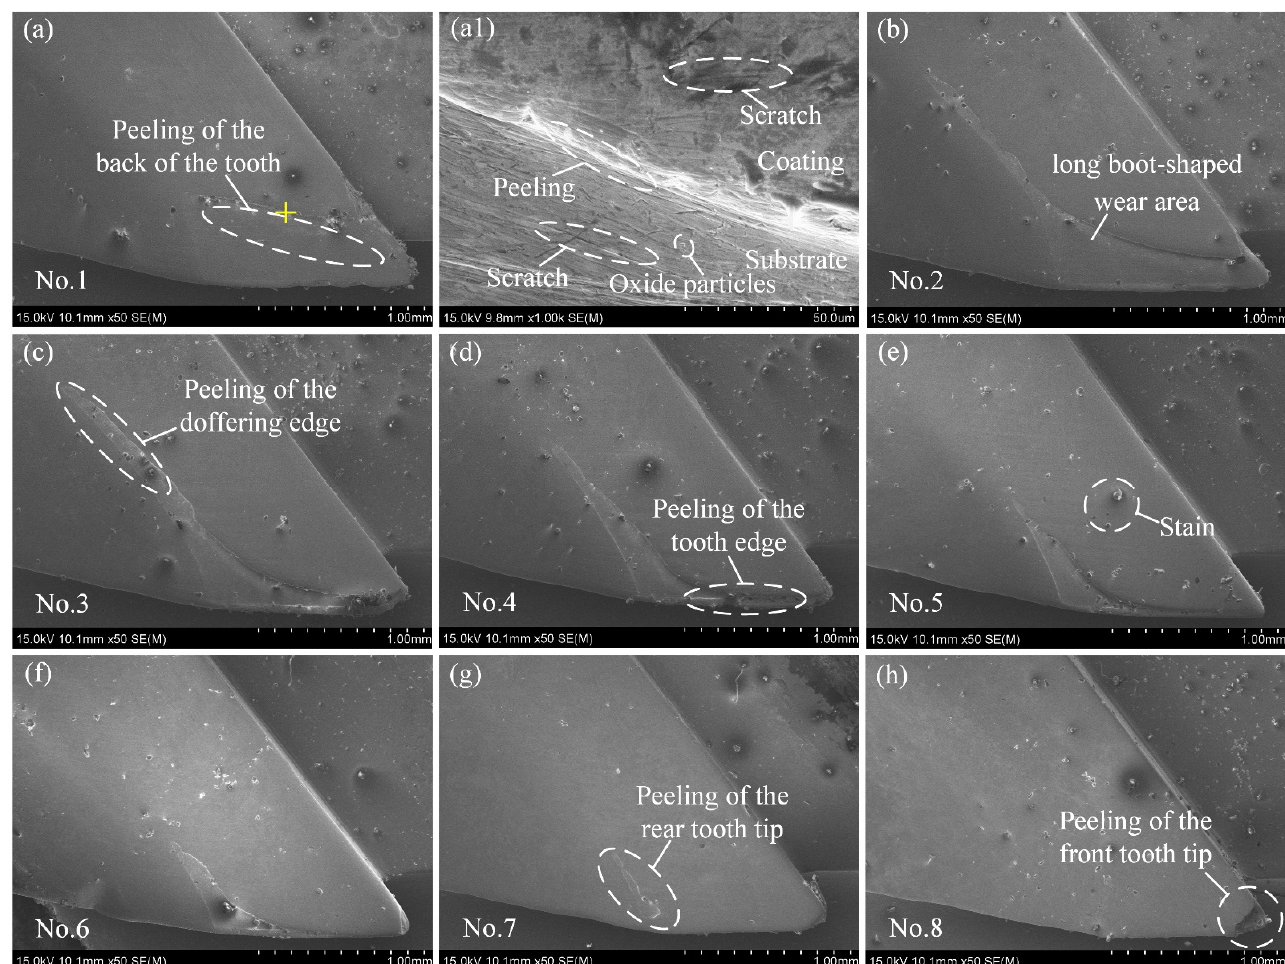
Figure 8. Wear morphology of hook teeth nos. 1 to 8 in a 450-hectare operation: ( a – h ) Wear morphology of hook teeth nos. 1 to 8; and ( a1 ) partial micrograph of the hook tooth nos. 1 mark. In sum, the wear of the spindle hook teeth starts from their front and rear tips before extending to their edges and back and then extending backward along the doffering edge to form a long boot-shaped wear area. Compared with hook teeth nos. 7 to 12, nos. 1 to 6 are more easily worn. The analysis results reveal that in the process of picking cotton, the hook teeth insert themselves into the cotton to hook the material, and given that the front and rear tooth tips are relatively sharp and the stress is concentrated, the front and rear tooth tips tend to be the first to wear out. In the process of picking cotton, the hook teeth on the edges and back of the teeth is prone to abrasive wear and even fatigue peeling [24].